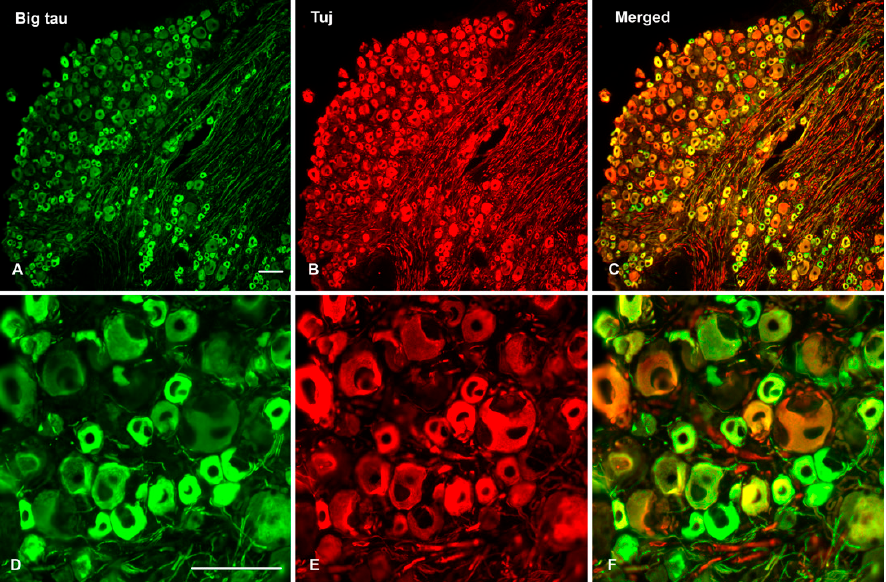
Figure 5. Histological analysis of Big tau expression in adult DRG tissue. Sections from adult DRG were double stained with Big tau and Tuj (neuronal marker) antibodies to analyze the expression and distribution of Big tau expression in DRG. The analysis shows selective staining of DRG neurons with Big tau ( A , D ) while Tuj stained all of the neurons ( B , E ), shown in merged image ( C , F ). The bottom panel shows high magnificent images derived from the top panel double stained for Big tau and Tuj ( D – F ) underscoring the selective of Big tau in DRG neurons mostly small and medium-sized neurons as confirmed in Figure S1. Scale bar = 100 μ m.